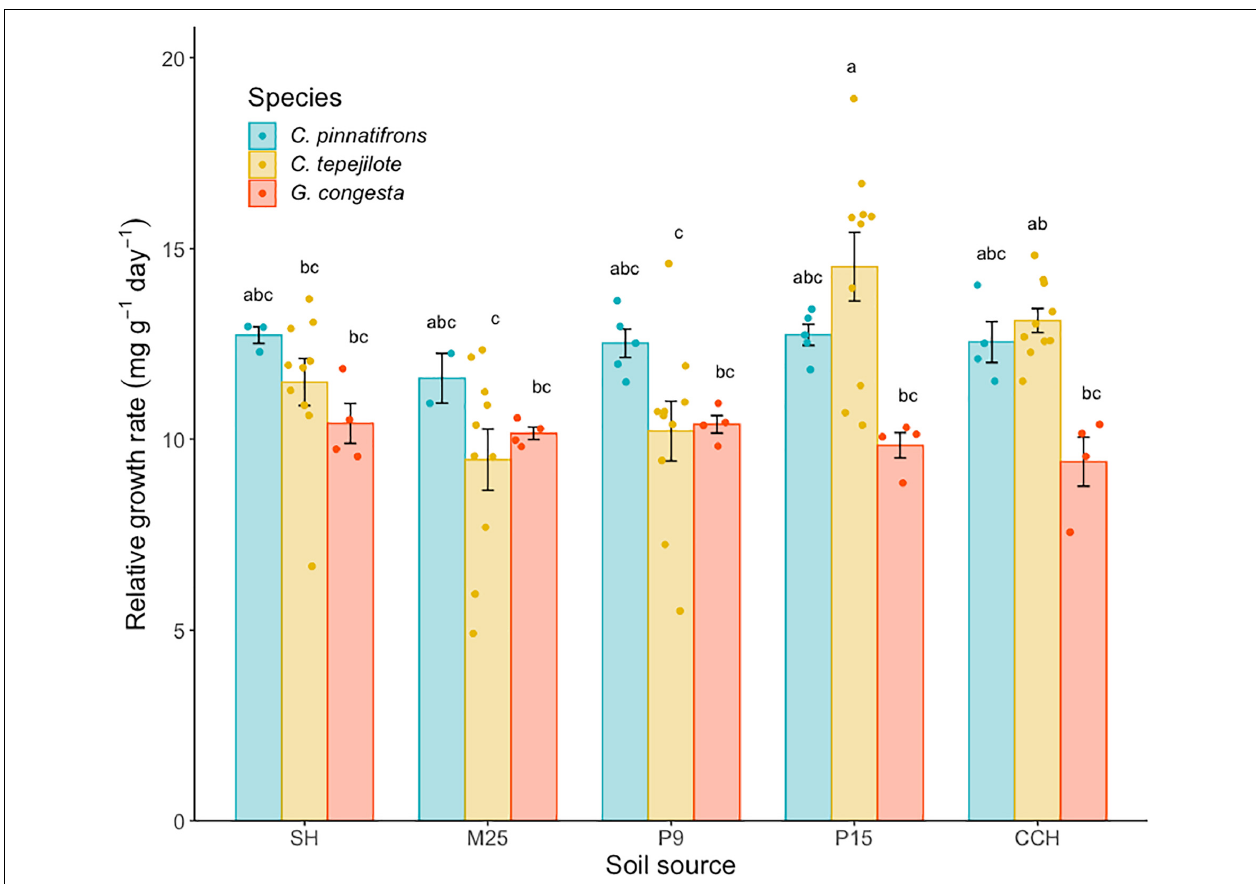
FIGURE 4 | Relative growth rate (RGR; mean ± SE) of seedlings growing in soil from five sites along a soil nutrient gradient. Soil sources are ranked and listed in order of increasing overall soil fertility. Bars are shaded by species. Different letters above the bars indicate statistically significant differences among means according to Tukey’s test ( P <